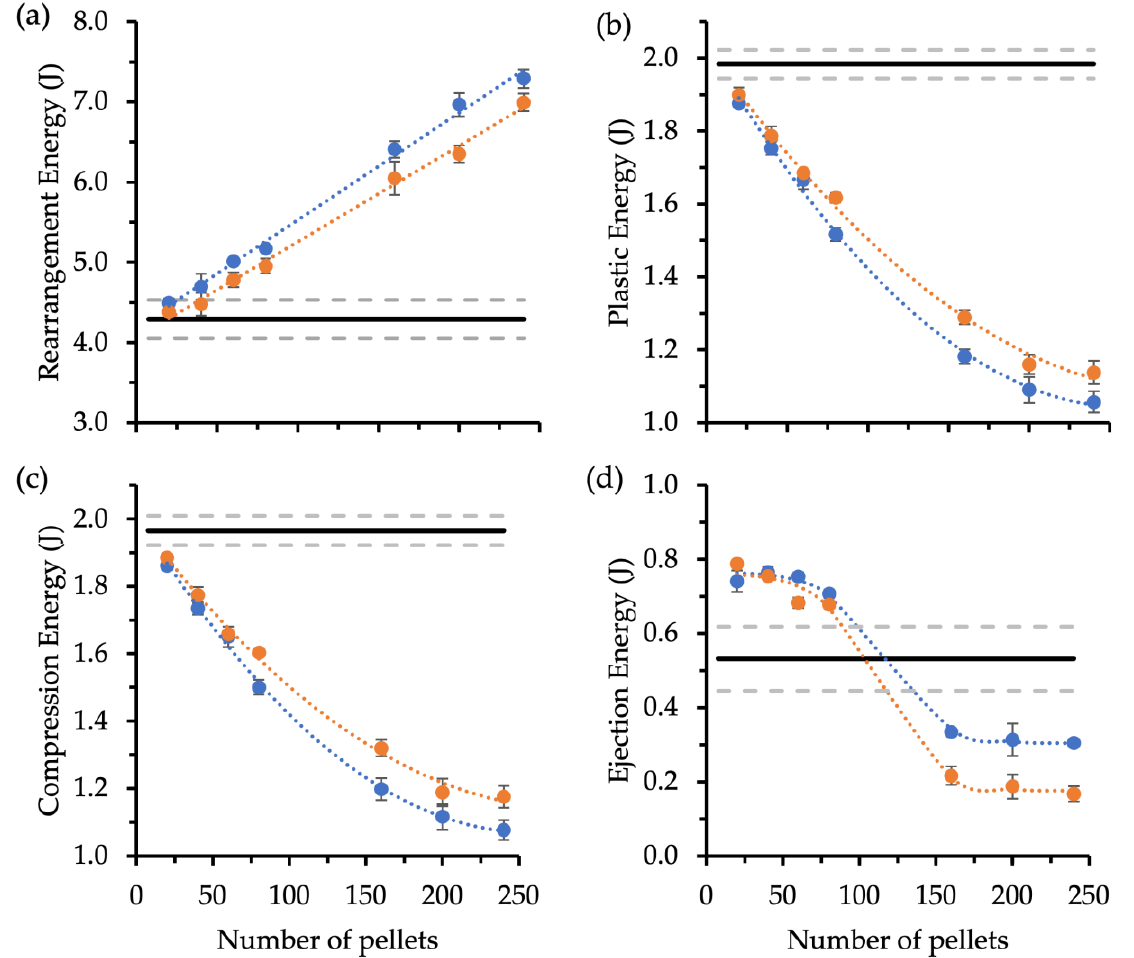
Figure 4. Plots of compaction energies over the number of MCC ( ) and XPVP ( ) pellets contained in the MUPS tablet ( n = 4). ( a ) Rearrangement energy, ( b ) plastic energy, ( c ) compression energy, and ( d ) ejection energy. Error bars represent the standard deviation. Trendlines (dotted) were fitted to discern trends. Control tablets ( n = 5) acted as the baseline, and their compaction properties are indicated by a horizontal line (solid) with the bracketing as standard deviation lines (dashed).